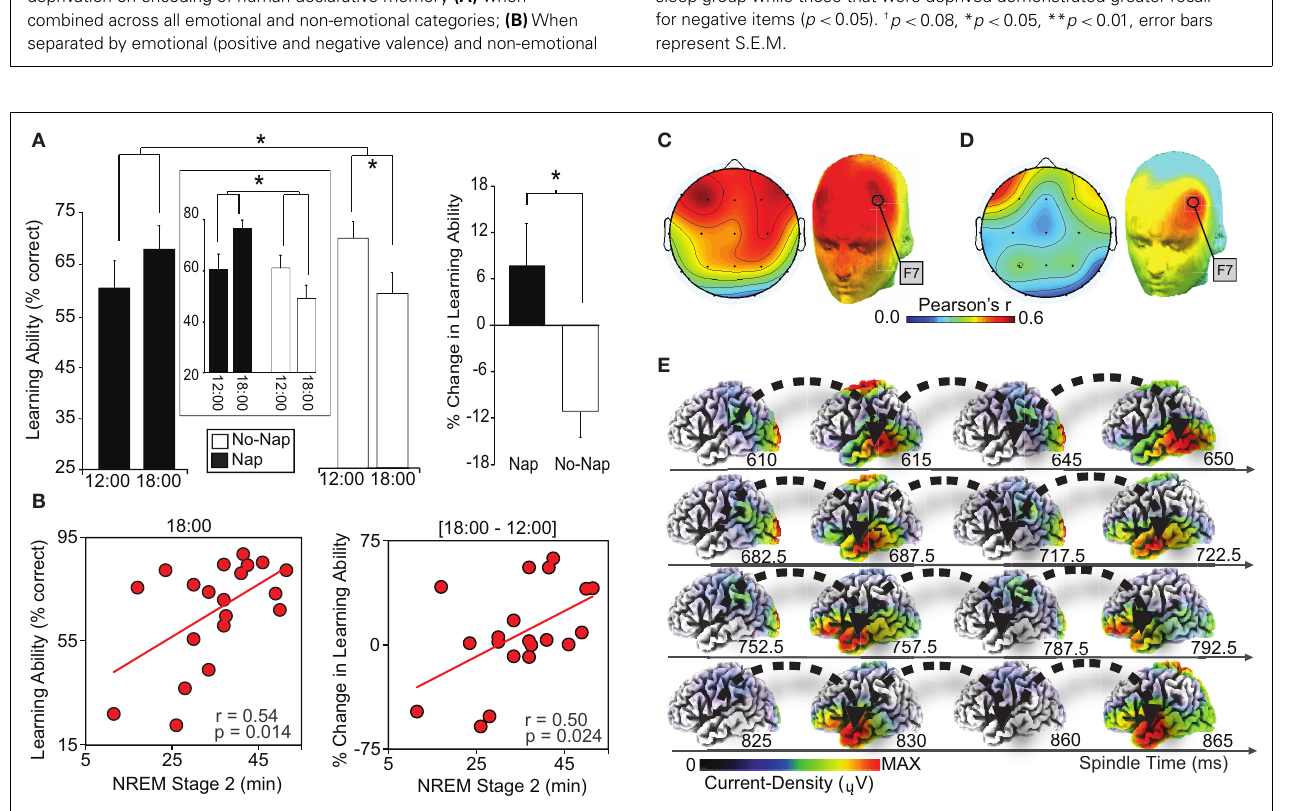
Topographic correlations (color-bar indicates Pearson’s correlation strength) in the nap group between fast sleep spindles and episodic learning ability at 18:00 (post-nap), significant in derivations F3, F4, Fz, F7, F8, Fp1, and Fp2 over PFC, maximal at F7 ( r = 0.536, p = 0.018). (D) Of these derivations, the change in episodic learning ability (18:00–12:00), significantly and conjointly correlated with fast spindles at derivation F7 over left PFC ( r = 0.535, p = 0.018). (E) sLORETA source time-series of fast sleep spindles identified by onset at F7, demonstrating a current-density loop recurring in left temporal lobe, proceeding the peak of the spindle. Modified from Mander et al.